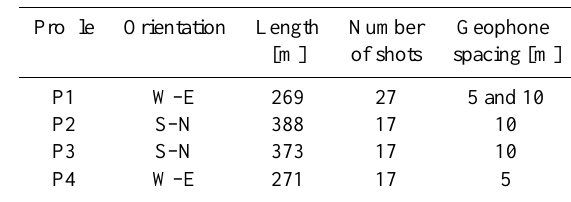
Table 1. Specifications of the seismic